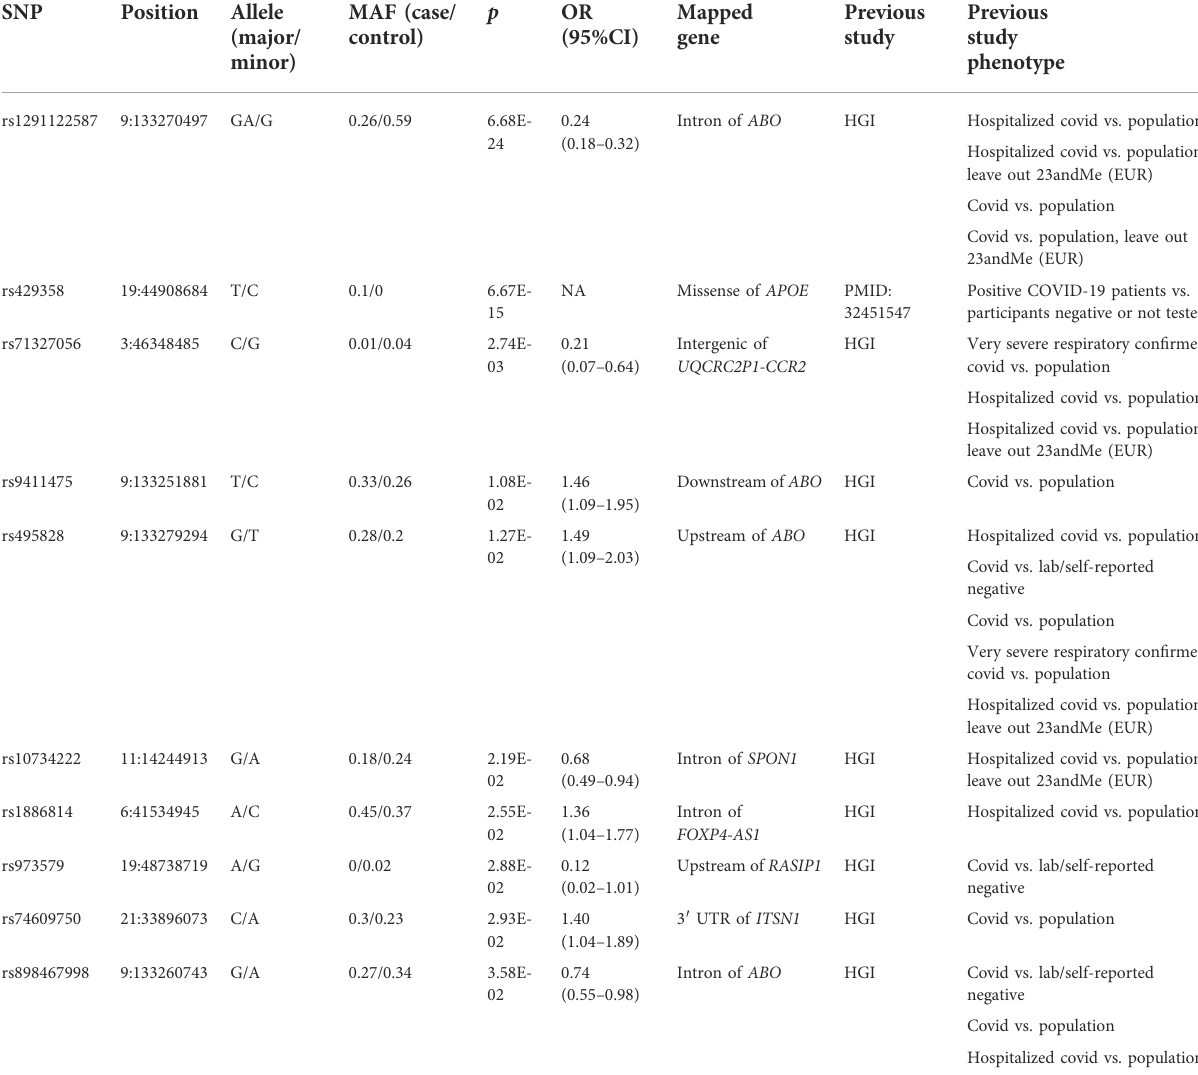
TABLE 3 Independent lead variants that were con fi rmed between all COVID-19 patients and general